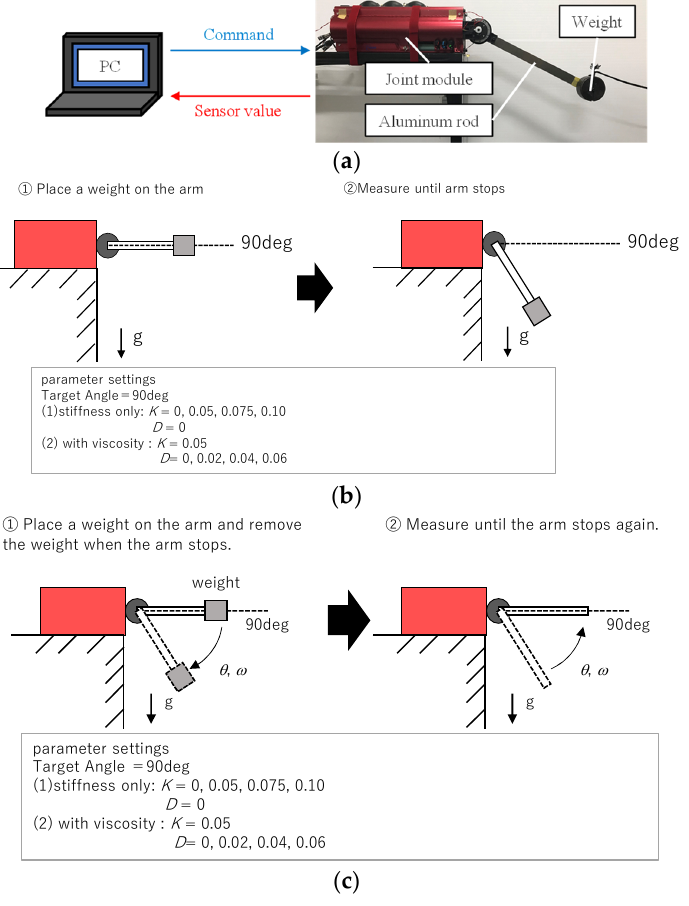
Figure 17. Diagram of the experimental environment for static load and load removal experiment. ( a ). Actual experimental environment diagram. ( b ). Flowchart of experimental environment for static load experiment. ( c ). Flowchart of experimental environment for load removal experiment.